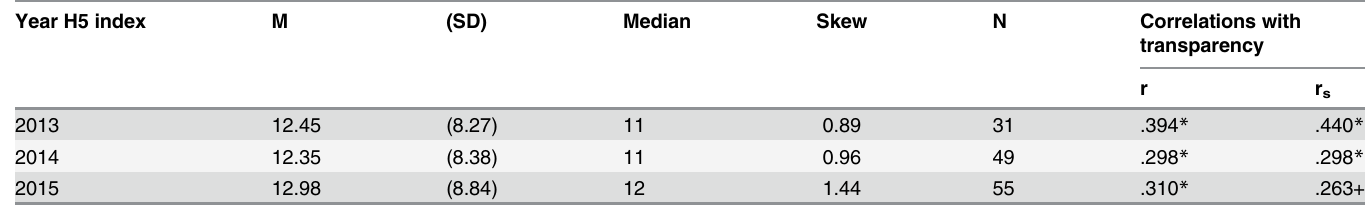
Table 5. Descriptive statistics for Google Scholar Metrics ’ H5-index from 2013, 2014, and 2015 and correlations with transparency in the DOAJ sample (Study 3, phase 1).